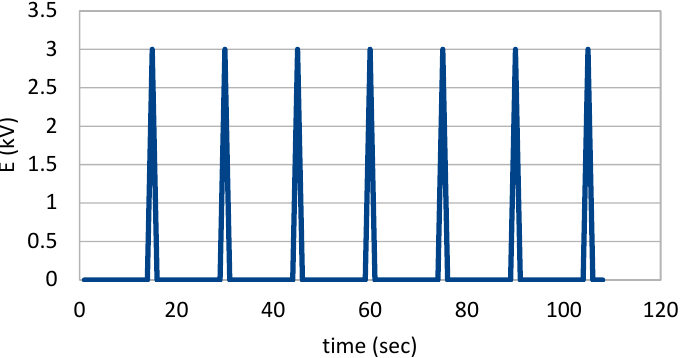
Figure 5. Time course of pulses used on the flow cuvette to execute electroporation. To verify the transfer of magnetic nanoparticles, Prussian blue staining was used to visualize them into the cytoplasm of microalgae cells (Figure 6a).